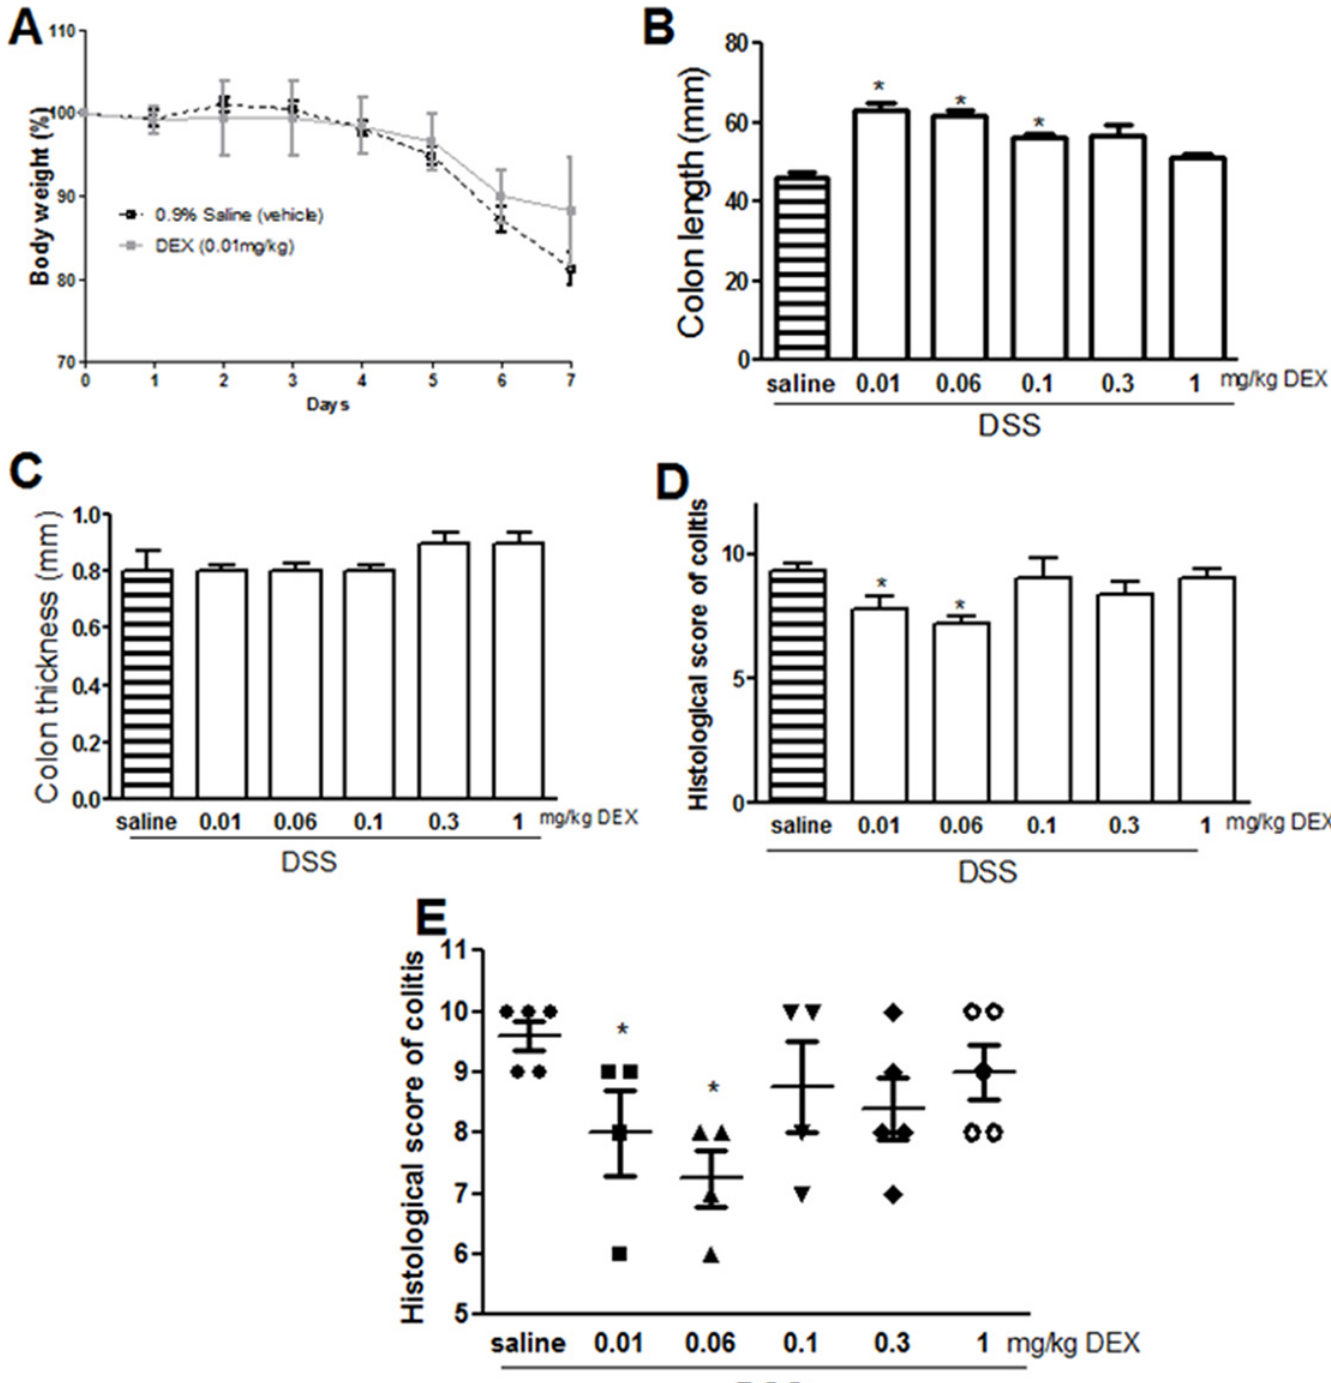
Fig 6. Effect of dexamethasone on colitis severity. Panel A shows % body weight change in saline (hatched line) or DEX treated (gray line) mice given DSS administration for 7 days. Panels B and C show colon length and thickness (in groups as indicated). Panels D and E represent histological assessment of colitis severity and the % of ulceration in the whole colon section respectively in the groups indicated. Histobars represent means ± SEM for 4 (DEX 0.01 mg/kg, DEX 0.06 mg/kg and DEX 0.1 mg/kg) or 5 (DSS/i.p saline, DEX 0.3 mg/kg and DEX 1.0 mg/kg) mice per group. Asterisks denote significant difference from DSS/ i.p saline treated mice with p <